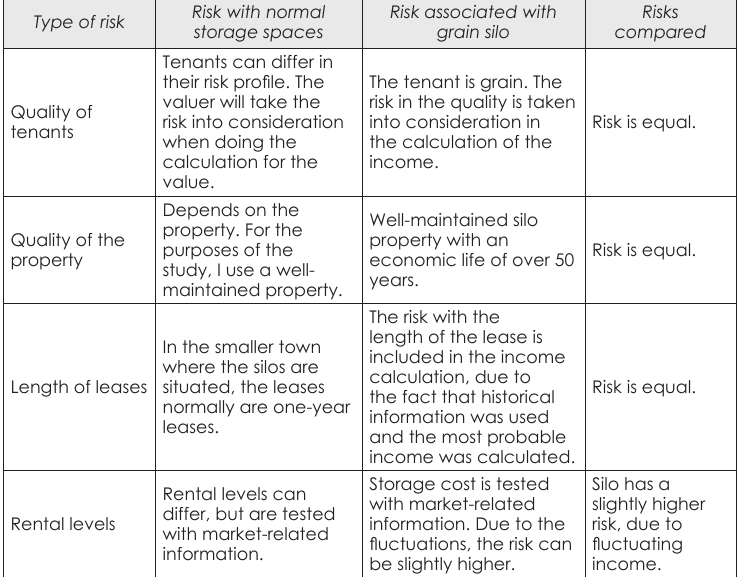
Table 11: Risks to consider when determining a capitalisation rate Type of